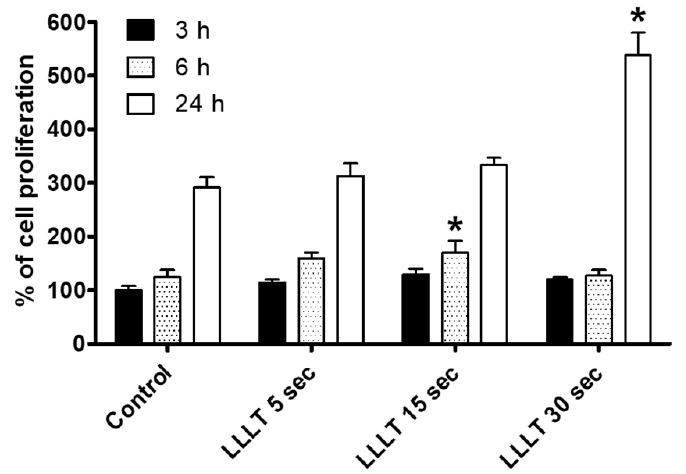
Figure 1. Cell proliferation affected by LLLT irradiation in RAW 264.7 cells. Cells were irradiated LLLT for 5, 15 and 30 s, then incubated for 3, 6 and 24 h. Cell proliferation measurement was conducted by MTT assay. Each value represents the mean ± S.D. * p < 0.05 compared with control.